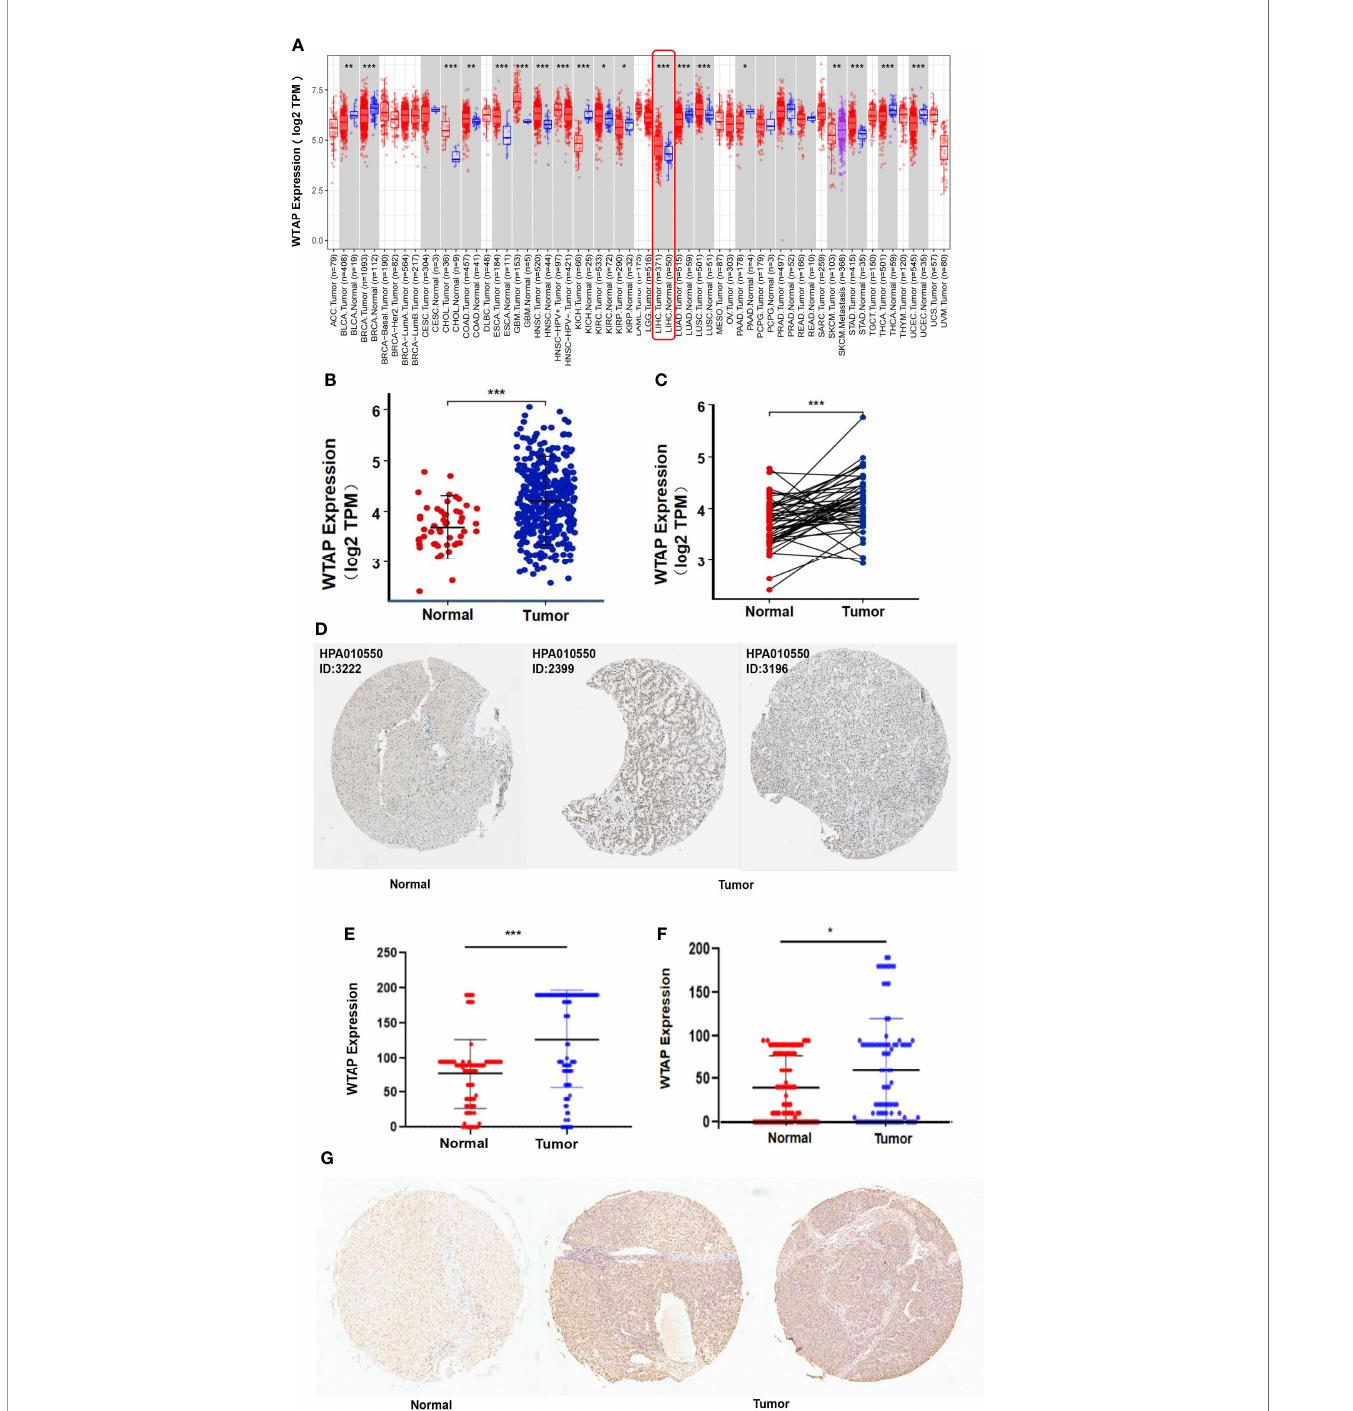
FIGURE 1 | WTAP expression analysis: (A) Comparison between tumor tissues of 33 types of cancer and healthy samples based on the TIMER database. (B, C) Comparison between unpaired or paired HCC tumor tissues and healthy samples derived from the TCGA dataset. (D) Immunohistochemistry images from The Human Protein Atlas of normal (left) and tumor tissues (right). (E, F) Comparison of total scores of immunohistochemical staining of the cytoplasm or the nucleus between normal and tumor tissues. (G) Immunohistochemistry images from tissue microarrays of normal (left) and tumor tissues (right). Data are presented as mean ± SD.* P < 0.05, **P < 0.01, *** P <